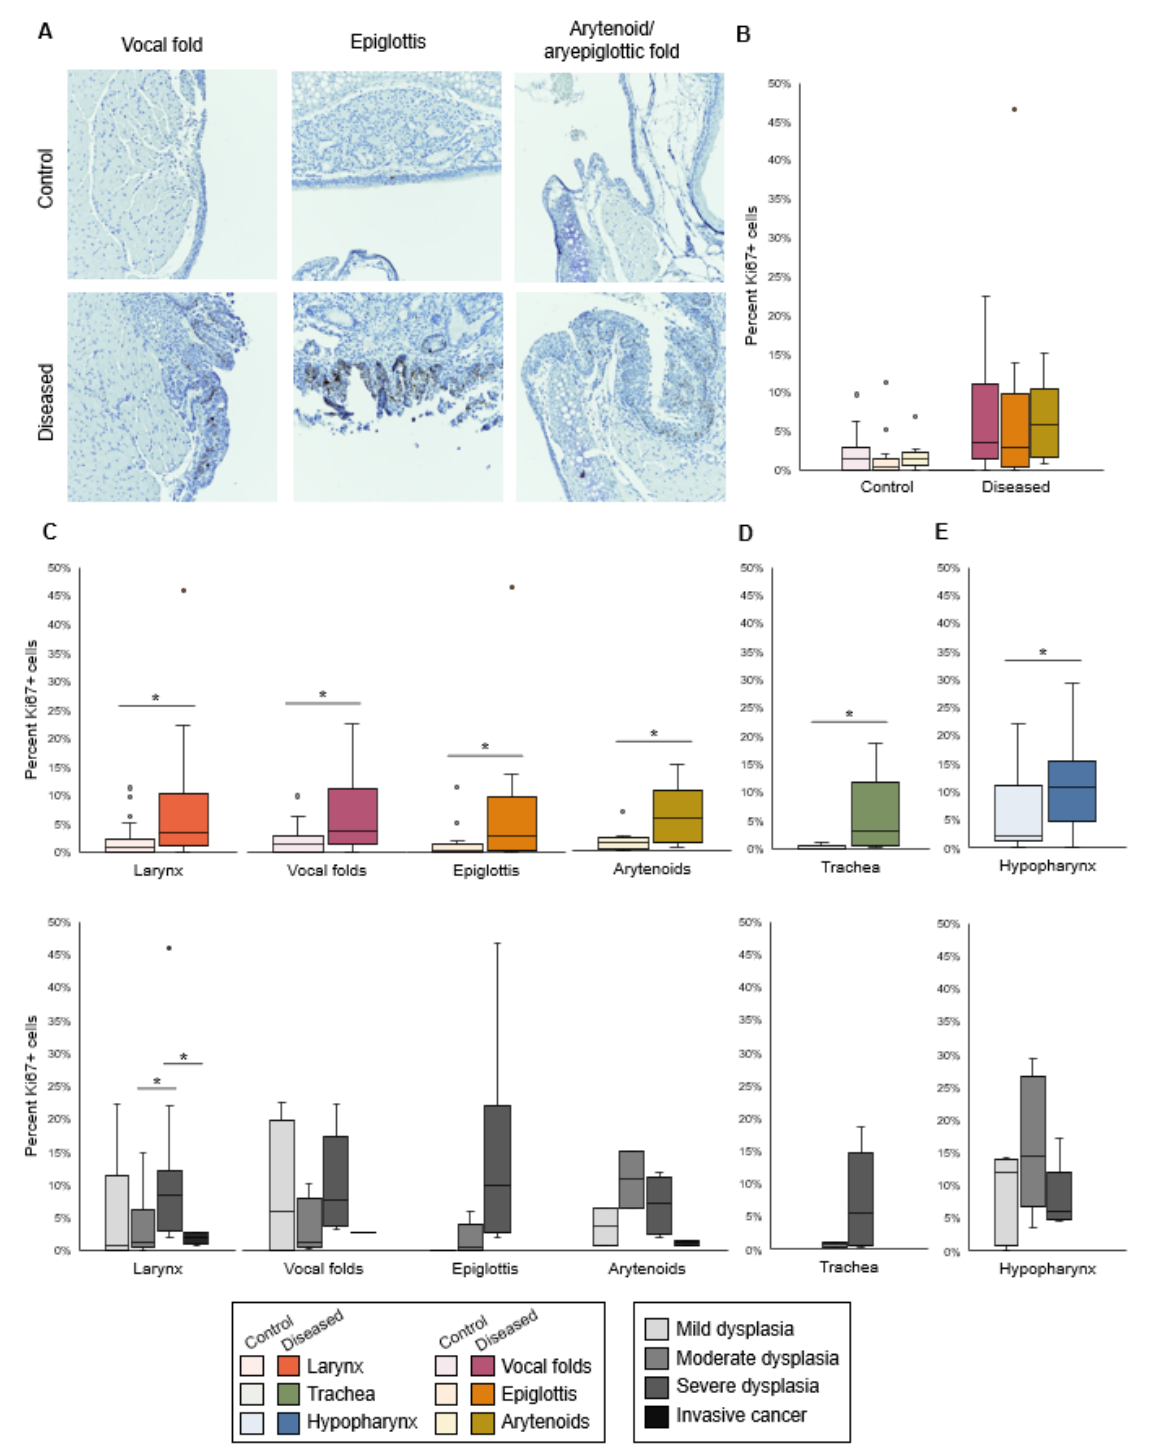
Figure 2. Proliferation index increased in diseased larynx, trachea, and hypopharynx. ( A ) Ki67 IHC stain in control and diseased vocal folds, epiglottis, and arytenoids, 30 × magnification. ( B ) Difference among laryngeal tissues in % Ki67+ cells, n = 12-16 mice per tissue type in each condition. Kruskal–Wallis tests: control p = 0.1647, diseased p = 0.6574. ( C ) Control vs. diseased laryngeal tissues and disease severity in laryngeal tissues. * Significant one-tailed Wilcoxon rank-sum tests for control vs. disease: larynx p < 0.0001, n = 41 mice per condition; vocal folds p = 0.0122, n = 16 mice per condition; epiglottis p = 0.0218, n = 13 mice per condition; arytenoids p = 0.0104, n = 12 mice per condition. Kruskal–Wallis tests for differences among severity levels: larynx p = 0.0212, n = 4–18